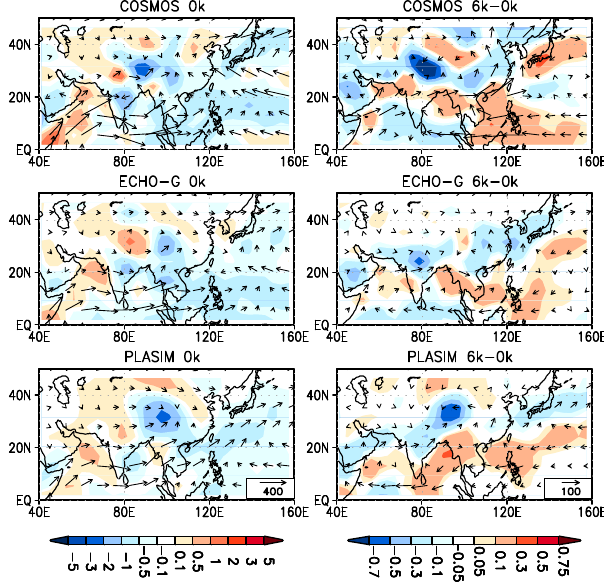
Figure 9. Simulated pre-industrial (summertime) vertically inte- grated moisture flux (vector, kgms − 1 ) and its convergence (shaded, 10 × 10 − 5 kgm − 2 s), i.e. convergence = blue (atmospheric mois- ture sink), divergence = red (atmospheric moisture source), as well as simulated change in vertically integrated moisture flux (vec- tor, kgms − 1 ) and its convergence (shaded, 10 × 10 − 5 kgm − 2 s) be- tween mid-Holocene and pre-industrial